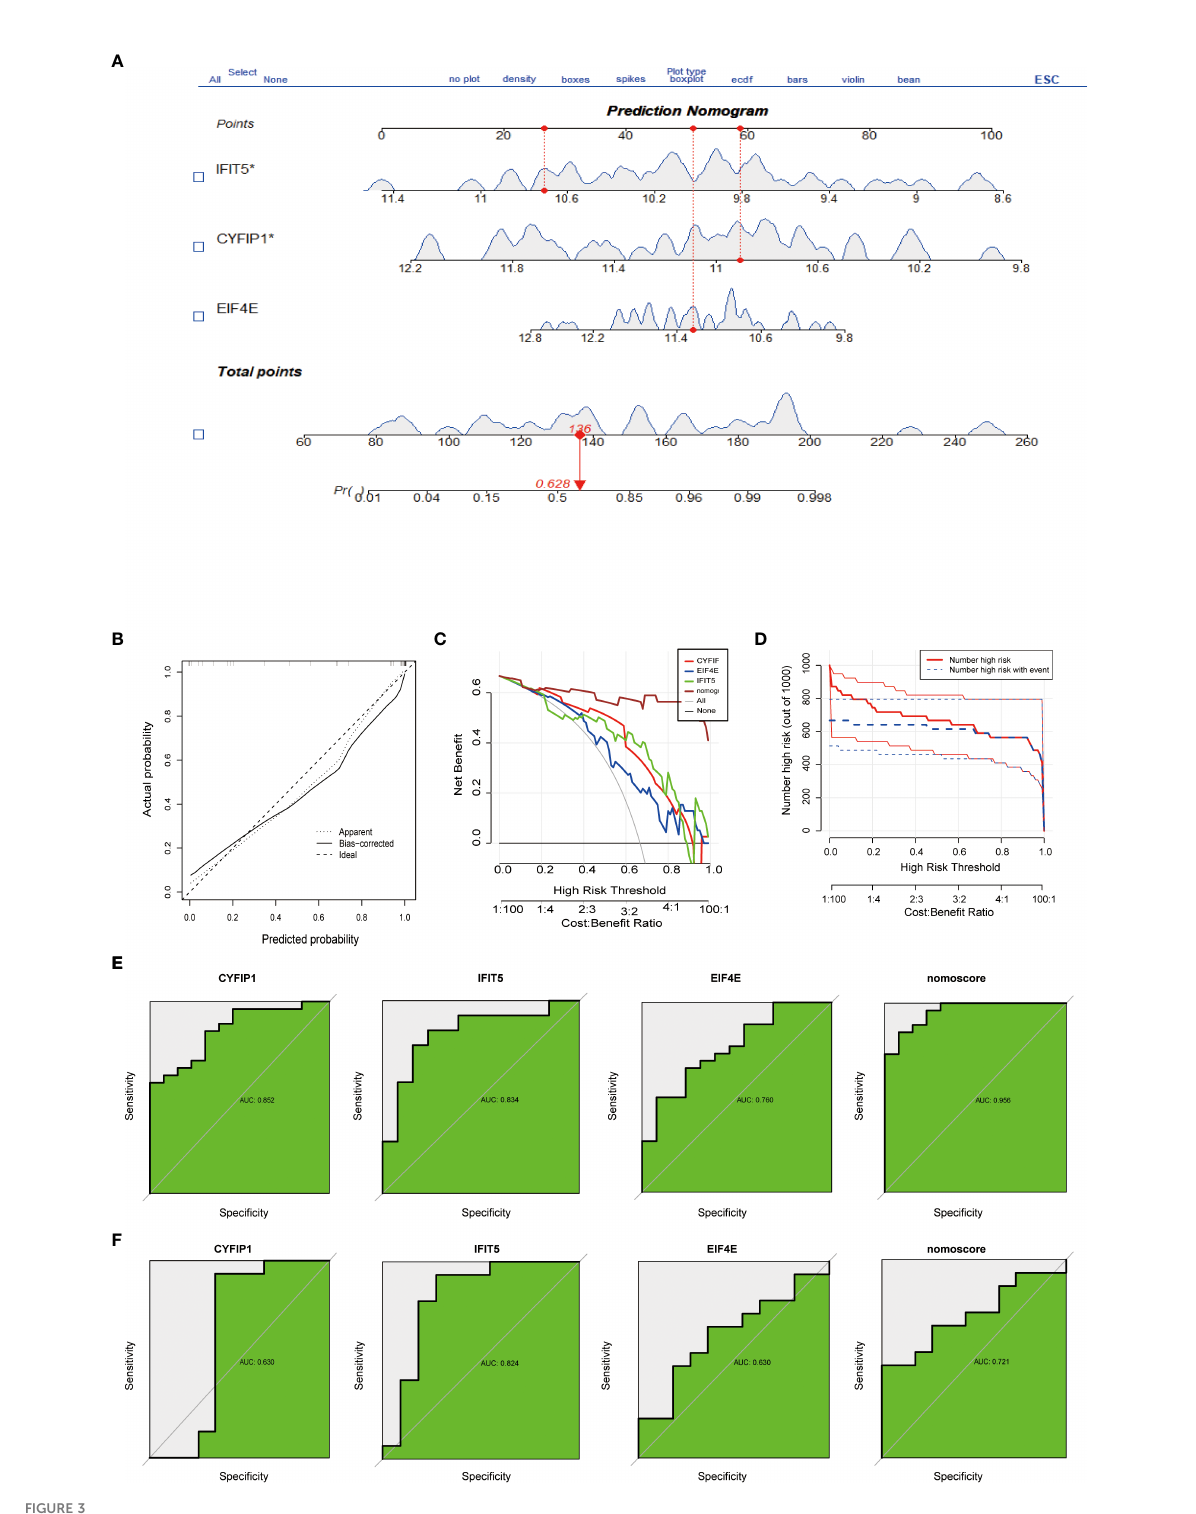
FIGURE 3 Construction and evaluation of a nomogram model for PAH diagnosis. (A) Nomogram model used to predict the incidence of PAH. (B) The calibration curve was used to assess the ability of the Nomo score model to predict. (C) The clinical value of the Nomo score model assessed by the decision curve. (D) Evaluation of the clinical impact curve of the Nomo score model based on the decision curve. (E) ROC curves of CYFIP1, EIF4E, IFIT5 and Nomo score in the GSE15197 dataset. (F) CYFIP1, EIF4E, IFIT5 and Nomo score ROC curve validation results in the GSE113439 validation set, AUC value is the area under the ROC